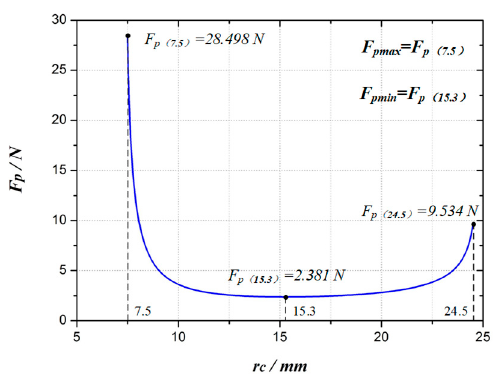
Figure 7. The curve of expanding force to expanding radius.